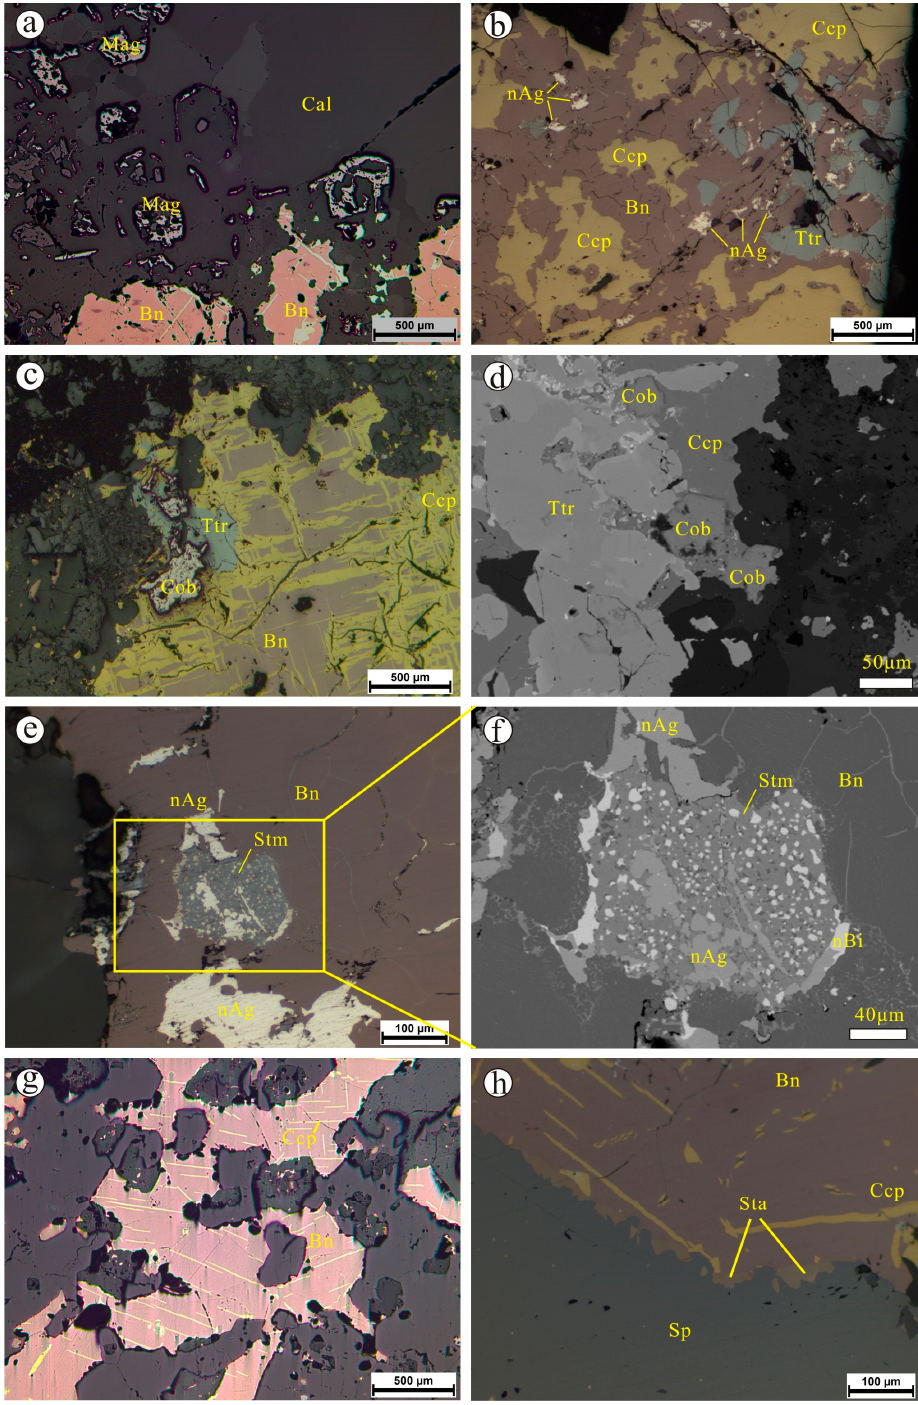
Figure 5. Reflected light ( a – c , e , g , h ) and backscattered electron images ( d , f ) showing textural relations of ore minerals. ( a ) Magnetite (Mt) replaces garnet (Grt), and filled by calcite (Cal); ( b ) bornite (Bn) replaces tetrahedrite (Ttr), and replaced by chalcopyrite (Ccp), with native silver (nAg) filling the fracture; ( c ) tetrahedrite replacing the chalcopyrite, chalcopyrite replacing the bornite, and cobaltite (Cob) replaced by tetrahedrite, chalcopyrite, and bornite; ( d ) cobaltite is subhedral to anhedral and replaced by chalcopyrite and tetrahedrite; ( e ) stromeyerite fills bornite, and is filled by native silver and native bismuth (nBi); ( f ) enlarged image of Figure 5e showing native silver and native bismuth fill stromeyerite (Stm), with native bismuth occurring later than native silver; ( g ) leaf-like texture of chalcopyrite in bornite; ( h ) stannoidite (Sta) occurring between bornite and sphalerite.